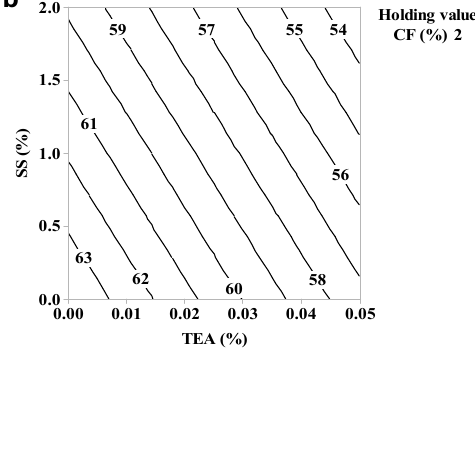
Figure 5. Effect of CF and TEA on the 7 d strength of cement mortars.